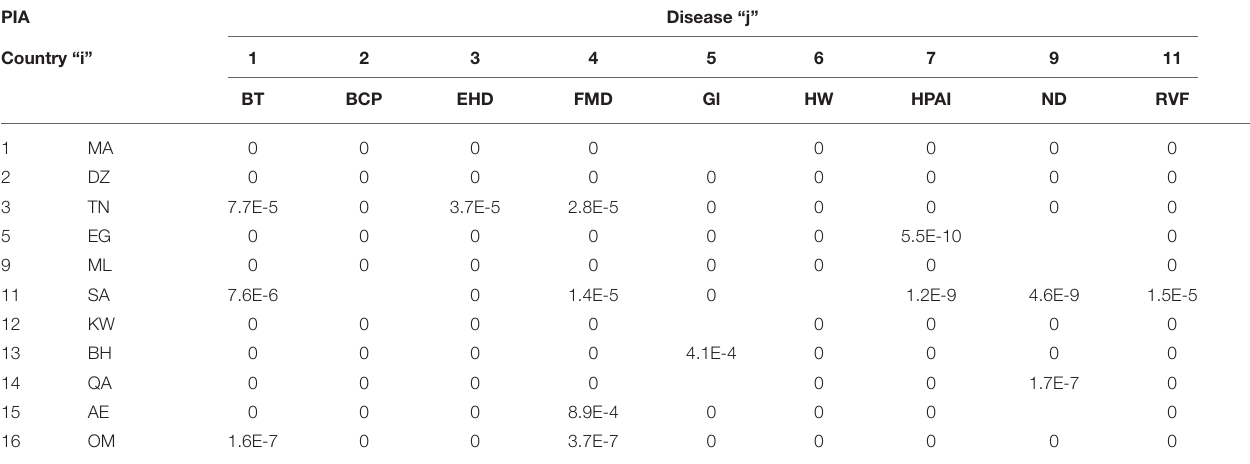
TABLE 4 | Probability of introduction of the j disease into the European Union through live animal’s trade from the country i . PIA Disease “j” Country “i”